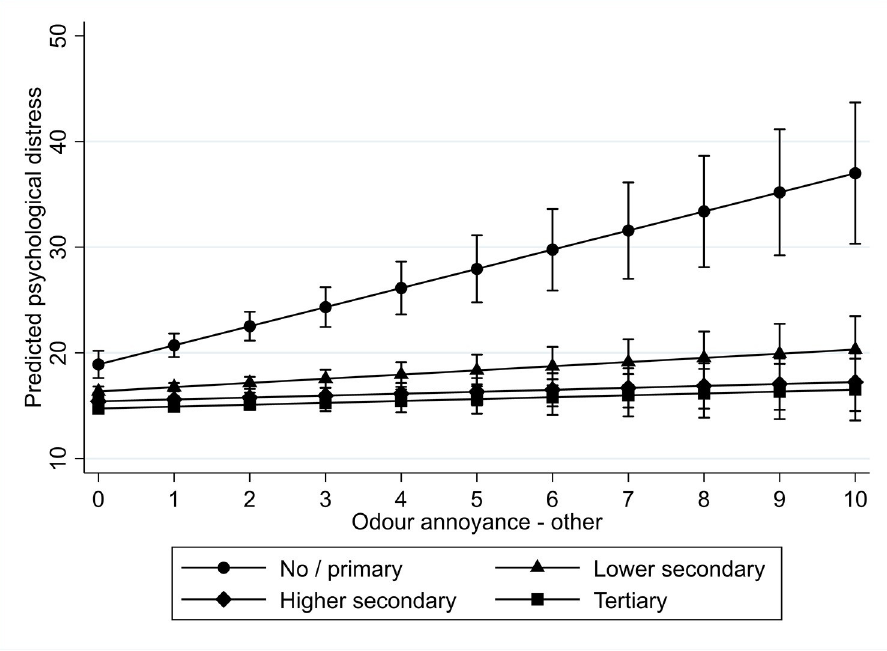
Fig 4. Interaction plot for predicted psychological distress among different educational levels by level of noise annoyance by other sources.